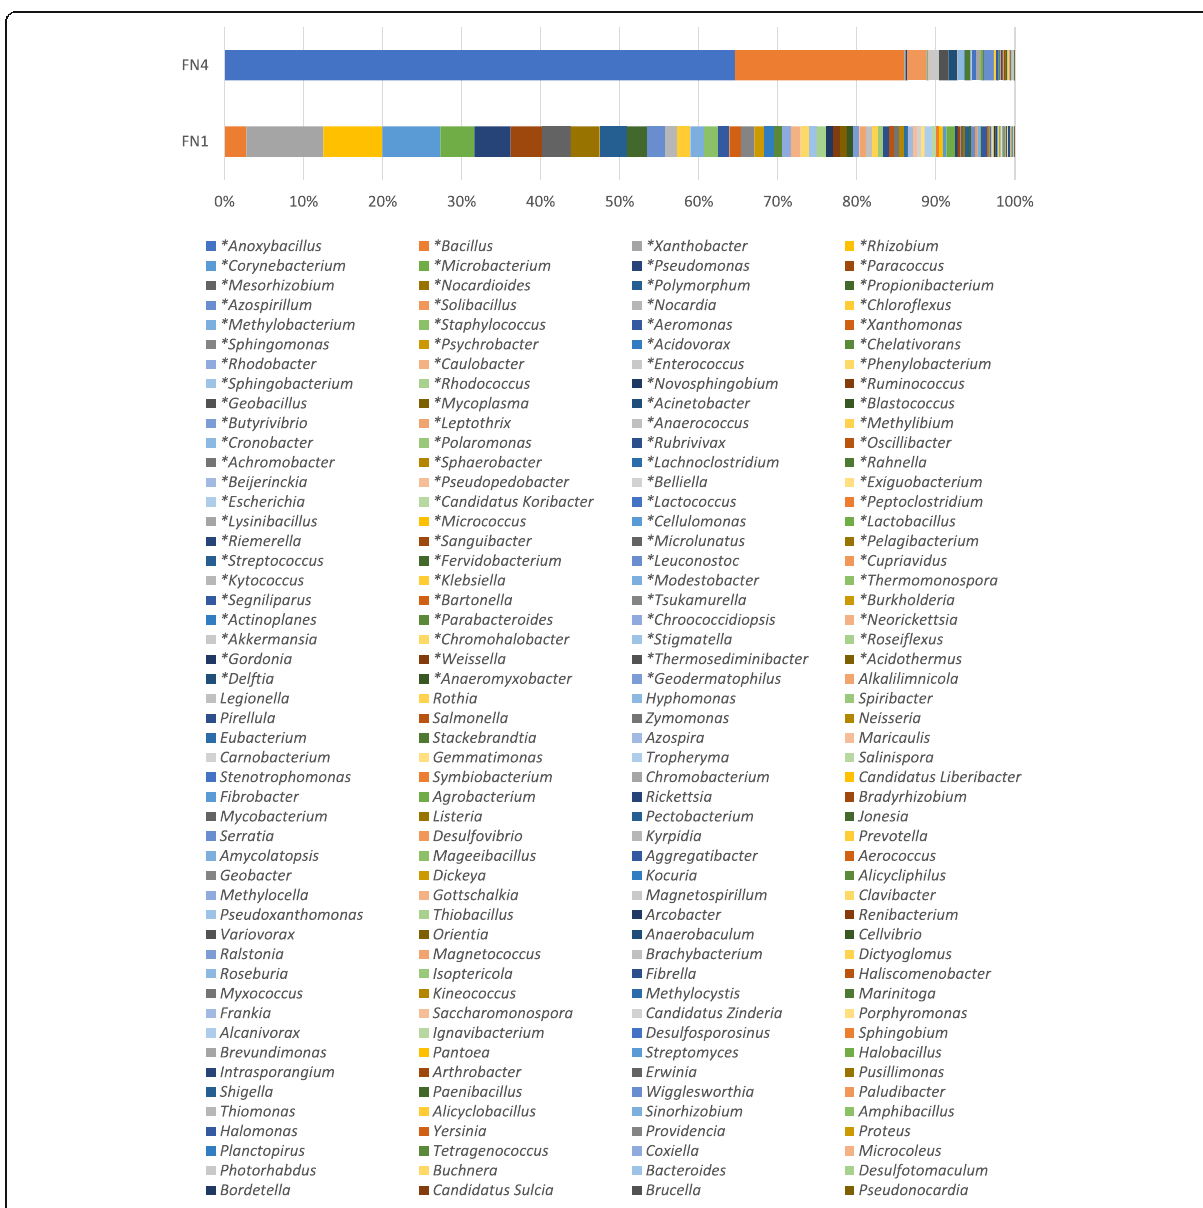
Fig. 3 Comparative taxonomic profile of the FN1 and FN4 metagenomes at genus delineation, computed by Kraken. All the genera detected in both metagenomes are shown. *Significant differences between FN1 and FN4 microcosms as determined by STAMP ( P < 0.05, difference between the proportions > 1% and twofold of ratio between the proportions, as determined by